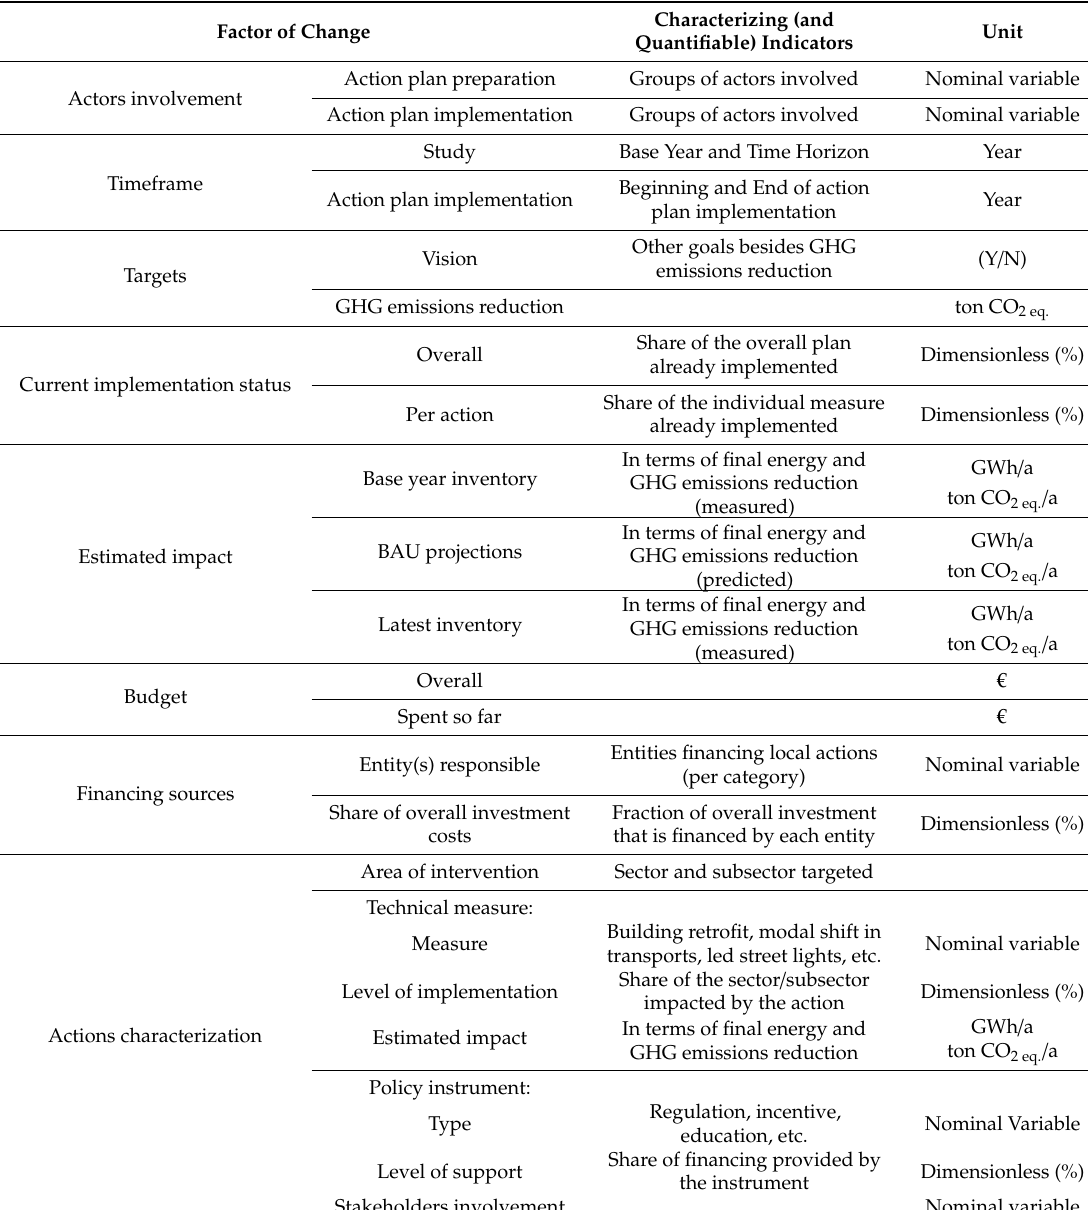
Table 7. Factors of change associated with local climate change mitigation actions with corresponding